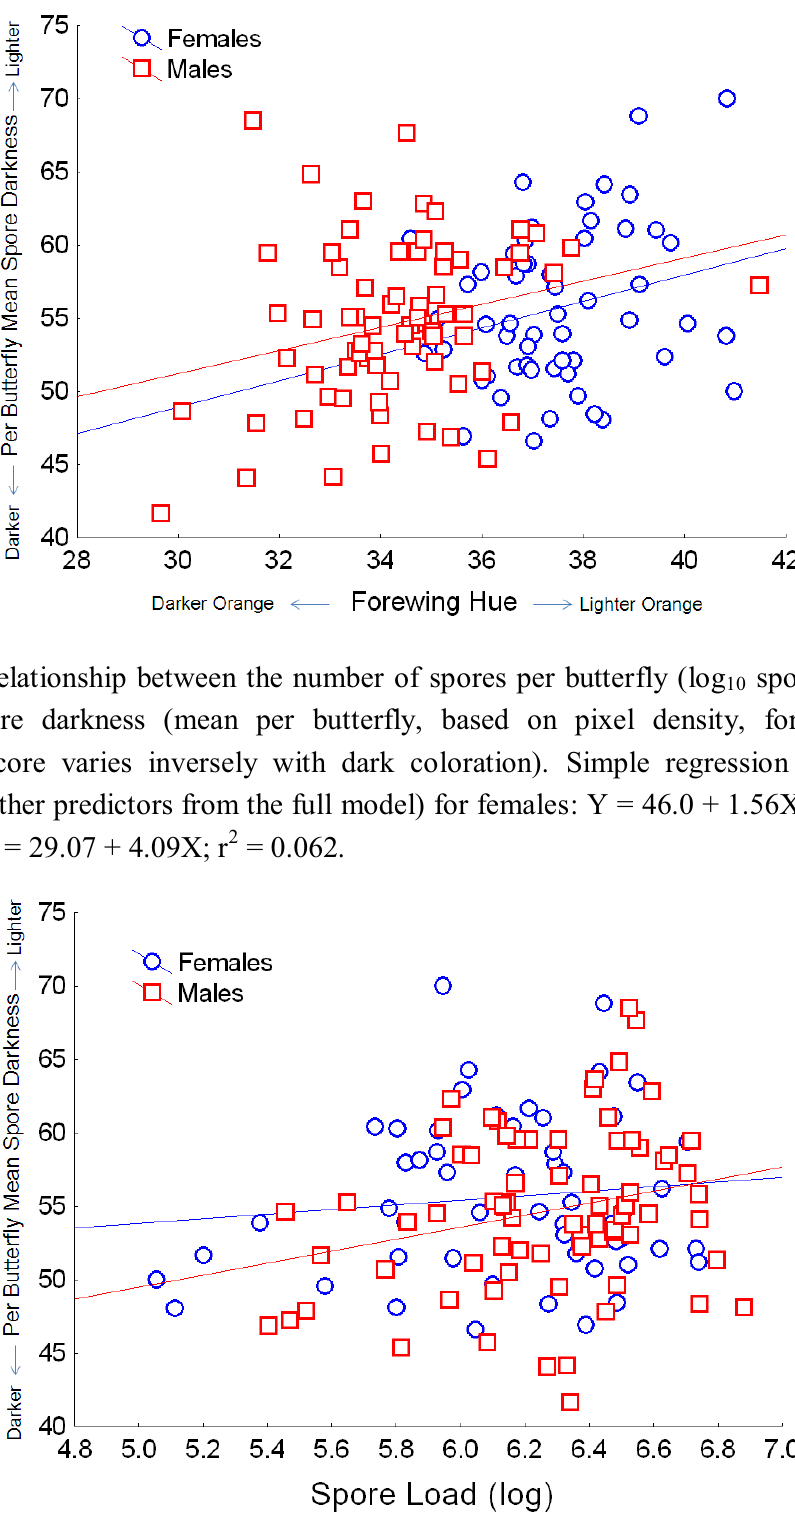
Figure 6. Relationship between the hue of orange on monarch wings (where lower values indicate redder hue, and higher values indicate yellow hue) and OE spore darkness (mean per butterfly, based on pixel density, for which the numerical score varies inversely with dark coloration). Simple regression relationship (excluding other predictors from the full model) for females: Y = 21.8 + 0.90X; r 2 = 0.063; for males: Y = 27.5 + 0.79X; r 2 = 0.070.